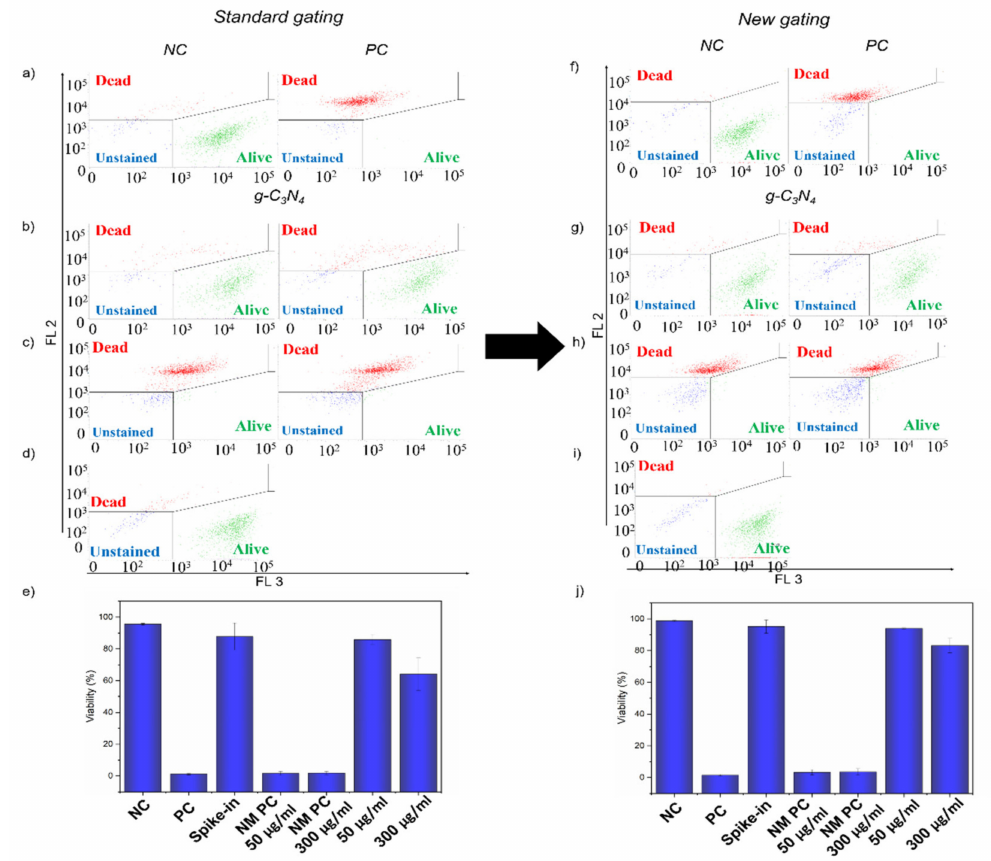
Figure 5. Dot plot showing LIVE/DEAD assay of: ( a , f ) negative and positive control of BJ cells and ( b – d , g – i ) BJ cells treated with g-C 3 N 4 samples with ( a – d ) standard gating and ( f – i ) new gating approach. ( b , g ) Samples treated with 50 µ g/mL ( left ) and 300 µ g/mL ( right ) of g-C 3 N 4 for 24 h; ( c , h ) Samples treated with NM PC 50 µ g/mL ( left ) and NM PC 300 µ g/mL ( right ); ( d , i ) Spike-in control for g-C 3 N 4 . ( e , j ) The evaluation of the viability of BJ cells treated with g-C 3 N 4 and additional control samples ( n = 3). The events in the alive gate are shown in green, events in the dead gate in red and events in the unstained gate are highlighted in